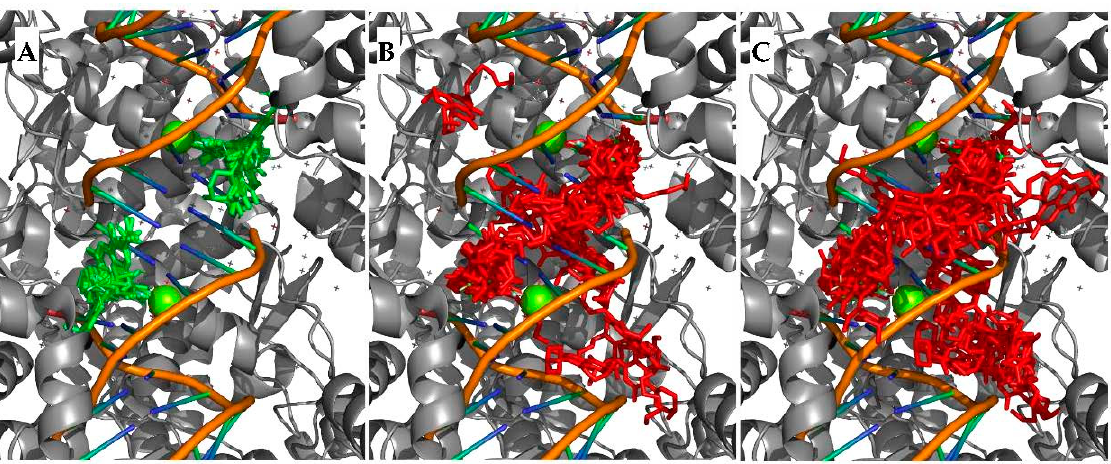
Figure 3. Top 50 poses obtained from the docking of levofloxacin ( A ), hexyl ester of LEV ( B ), and nonyl ester of LEV ( C ).